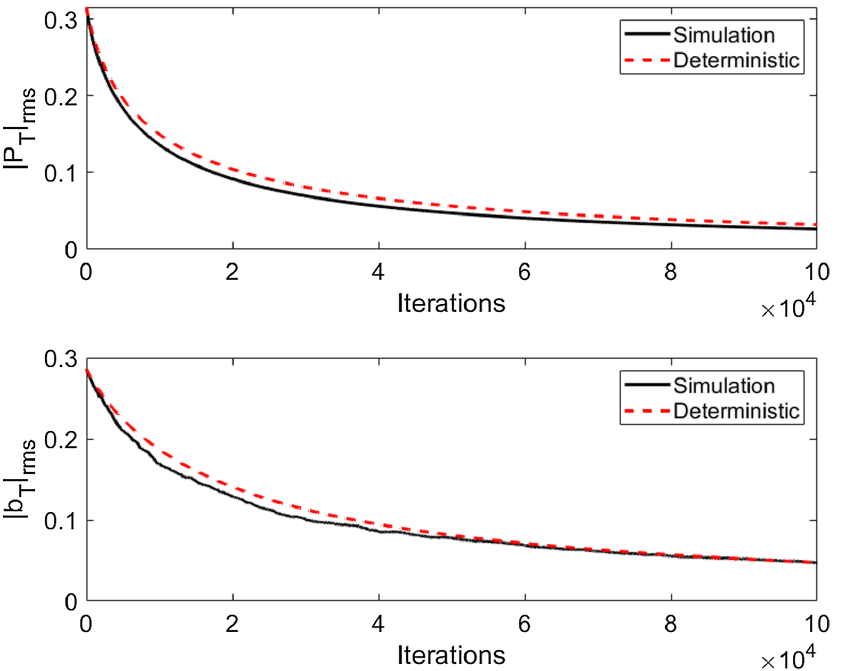
ˆ P σ 0 . 1 mm and T j 2 (dashed red) for a configuration with w ¼ ˆ b T (solid black) and T (dashed